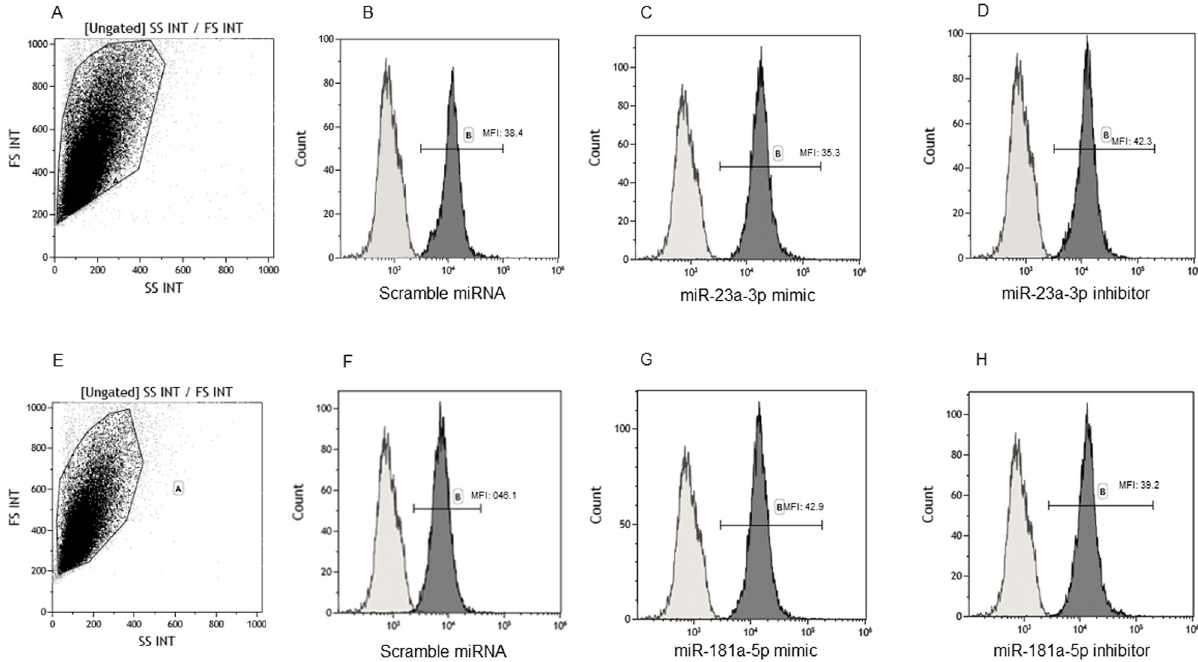
Fig 3. SNAP-25 immunostaining in MO3.13. Representative results obtained by staining MO3.13 with mAbs specific for SNAP-25. Gate on forward and side scatter plot (a and e) and (in dark grey diagrams) SNAP-25 signal intensity of MO3.13 cells transfected with scramble miRNA (b and f), miR- 23a-3p mimic (c), or inhibitor (d), and miR-181a-5p mimic (g), or inhibitor (h). Light grey diagrams in b, c, d, f, g and h represent the isotype control. MFI: mean fluorescence intensity.